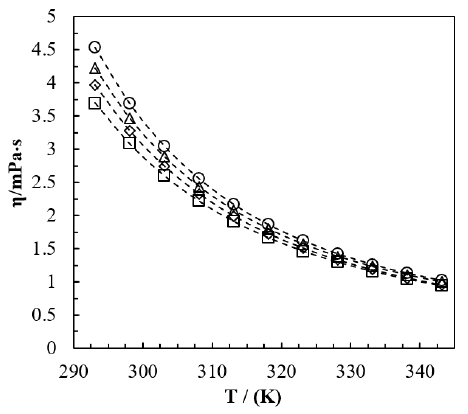
Figure 3. Viscosity of: ( a ) MDEA + MEA + H 2 O, ( b ) DMEA + MEA + H 2 O, and ( c ) DEEA + MEA + H 2 O mixtures in the temperature range 293.15 K–343.15 K. Table 14. Binary parameters 𝐴 0 , 𝐴 1 , and 𝐴 2 of the equation Δ𝐺 𝑗𝑘 𝐸∗ = 𝑥 𝑗 𝑥 𝑘 ∑ 𝐴 𝑖 (𝑥 𝑗 − 𝑥 𝑘 ) excess free energy of activation for the viscous flow of MDEA (1) + MEA (2) + H 2 O (3).